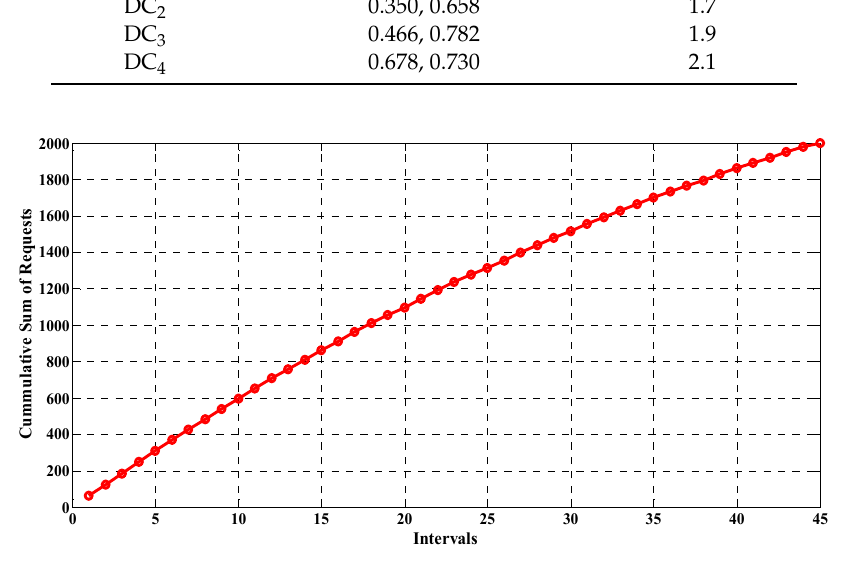
Figure 3. VM Request arrival